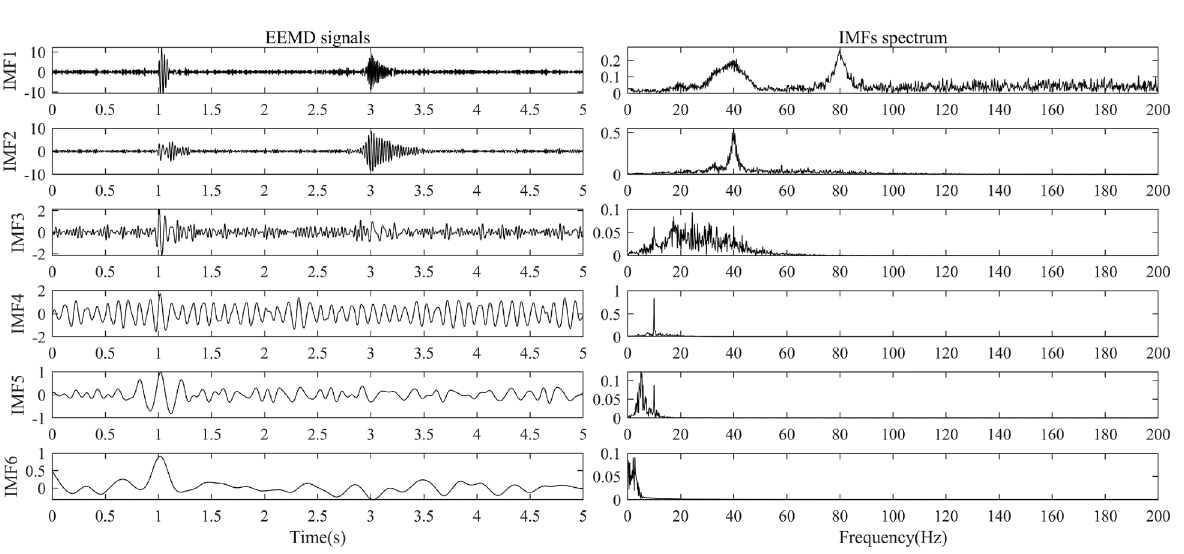
Figure 8 The simulation signal EEMD components and their